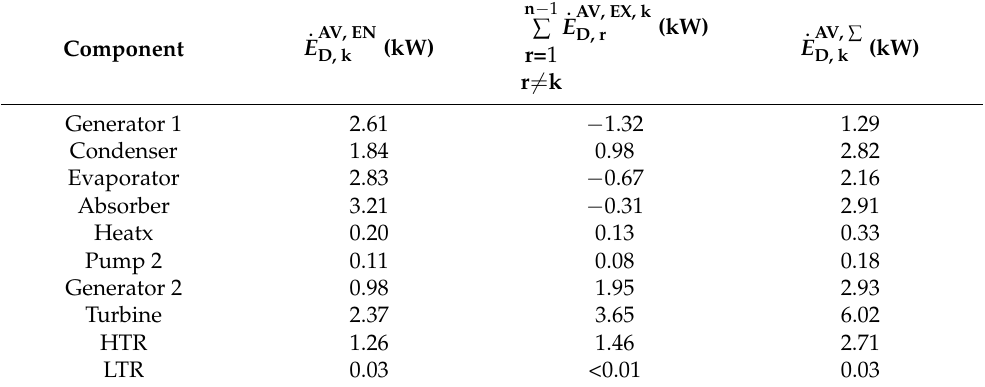
Table 6. Component improvement